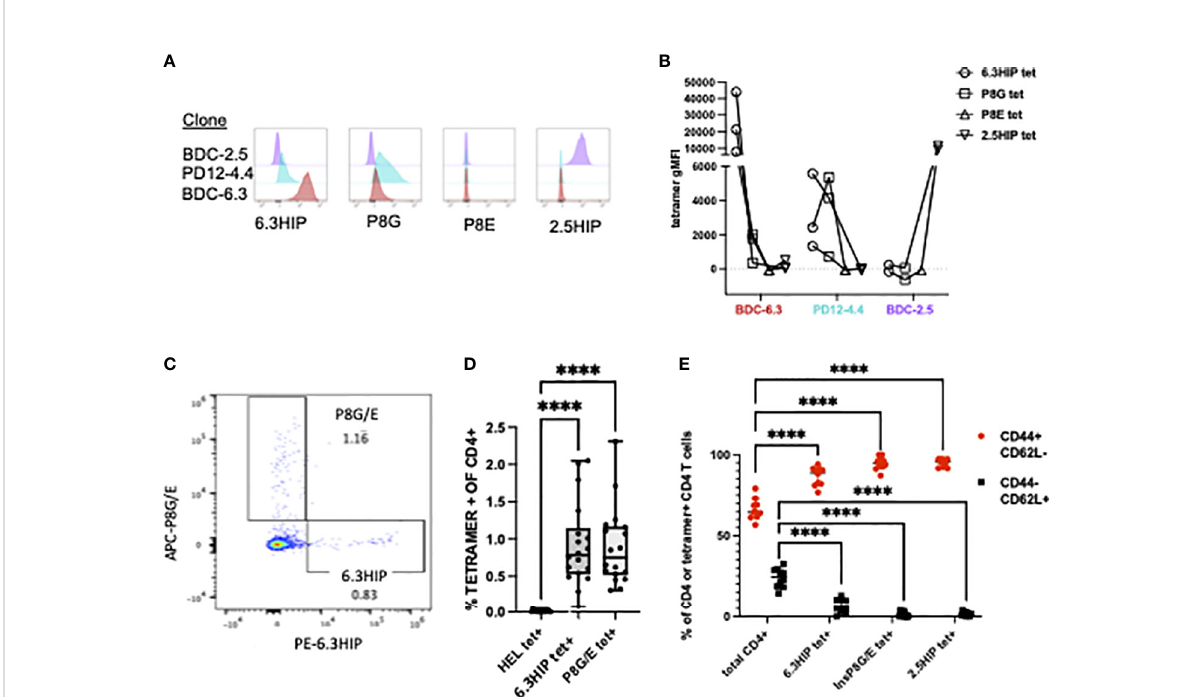
FIGURE 6 MHC Class II tetramer staining of CD4+ T cell clones and islet in fi ltrating CD4+ T cells. Representative histograms of (A) T cell clones BDC-2.5 (purple), PD12-4.4 (blue), and BDC-6.3 (red) stained with 6.3HIP, P8G, P8E, and 2.5HIP tetramers and the (B) geometric MFI from 2-3 experiments with lines connecting tetramer stains conducted on the same day. (C) Representative CD4 T cells from NOD islets stained with a mixture of I-A g7 tetramers loaded with the P8G/E insulin mimotopes and 6.3HIP, and labeled with APC and PE, respectively. (D) Summary of results of the analysis of in fi ltrating CD4+ T cells from the islet isolations from a total of 18 NOD mice (5 separate islet isolations) stained with hen egg lysozyme (HEL), 6.3HIP and P8G/E tetramers. Data represented as percent of live lin - CD4 + T cells positive for each tetramer/animal and analyzed using a one-way ANOVA with Tukey ’ s multiple comparison test, (****P<0.0001) where the box de fi nes the interquartile range, and the whiskers indicate minimum and maximum values. (E) Summary data (n=10) comparing the proportion of CD44+ and CD62L+ in total CD4 T cells or tetramer+ CD4 T cells within islets. A two-way ANOVA was used with Dunnett ’ s multiple comparison test to assess the antigen experience phenotype of CD4 T cells staining with each tetramer compared to the total CD4 in fi ltrate as a control (****P<0.0001). Gating strategy for tetramer staining of T cells is provided in Figure